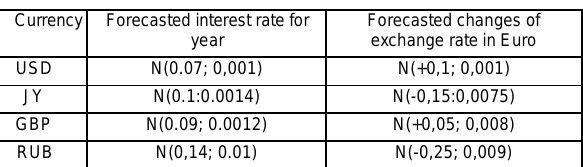
Currency Forecasted interest rate for